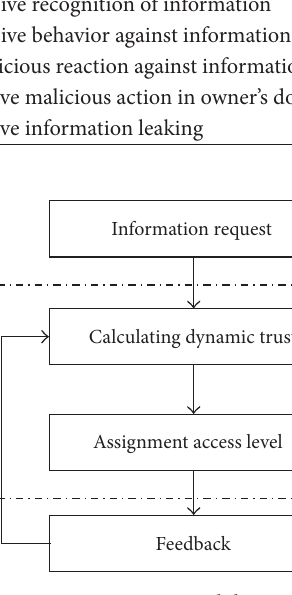
Figure 1: Proposed dynamic access control